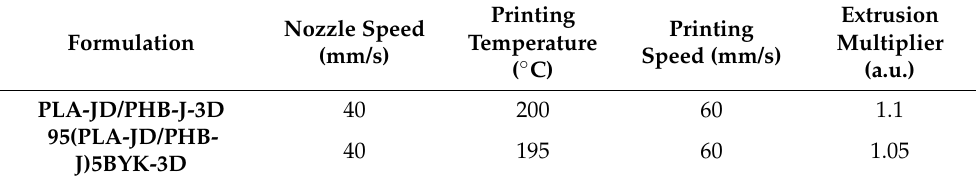
Table 2. Printing parameters for the PLA/PHB blend with and without nanoclay.